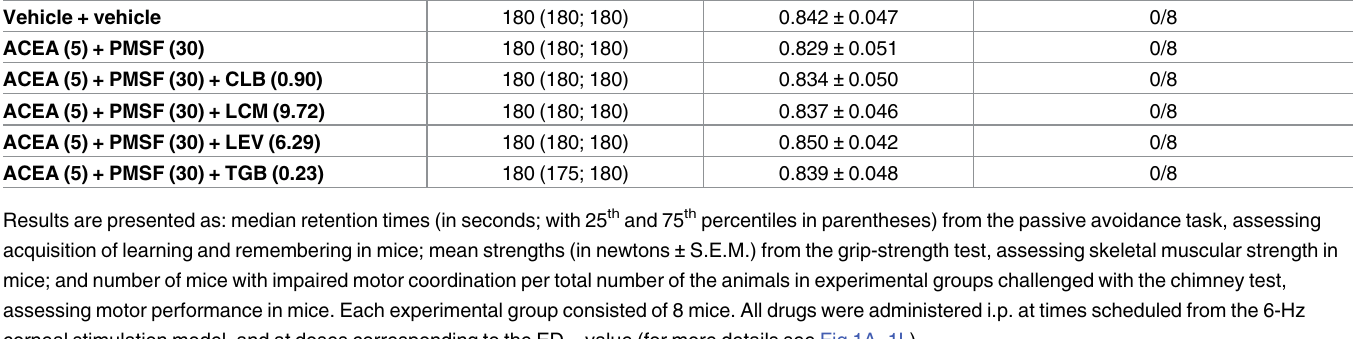
Table 1. Effects of ACEA and PMSF in combinations with clobazam (CLB), lacosamide (LCM), levetiracetam (LEV) and tiagabine (TGB) on long- term memory in the passive avoidance task, muscular strength in the grip-strength test and motor performancein the chimney test in mice.